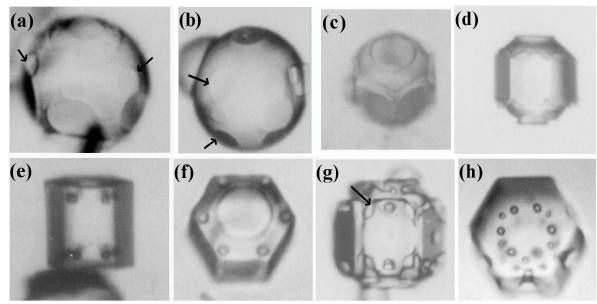
Figure 1. Crystals at different stages between large droxtals (just- frozen droplets) and prisms at temperatures between − 6 and − 12 ◦ C and supersaturations near liquid-water saturation. Top row shows initial development of basal and prism faces, with some pyra- midal faces (marked with arrows) in (a) and (b) . Bottom row shows filled-out faces with corner pockets in (e) and (f) . In (g) and (h) , pockets appear where pyramidal faces may have hollowed before being overtaken by basal and prism faces. Arrow in (g) marks an ap- parent protrusion. Diameters are within 45–90µm. (From the cloud chamber, courtesy of Akira